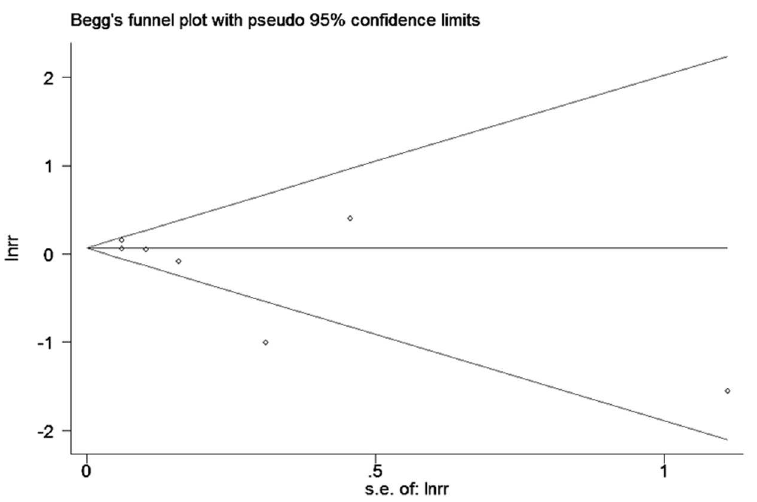
Fig 5. Funnel plots of categorical variable results included in